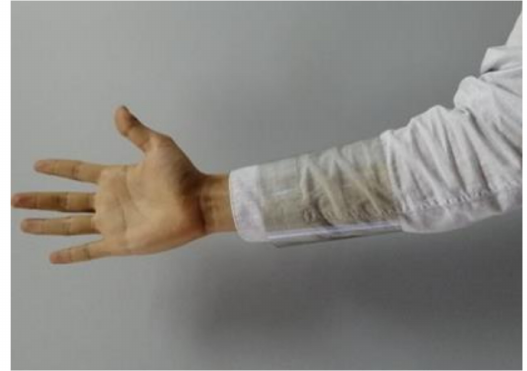
Figure A2. Illustration of the flexibility of the PAIP sample.